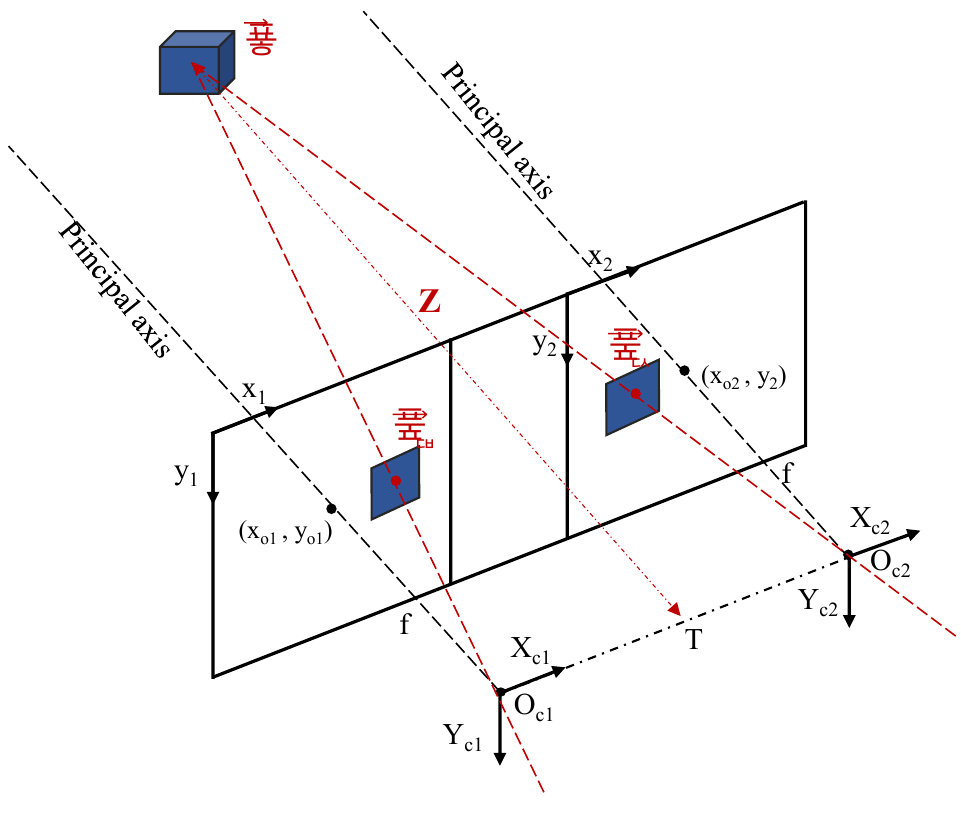
Figure 4. Schematic of the two-chamber model.